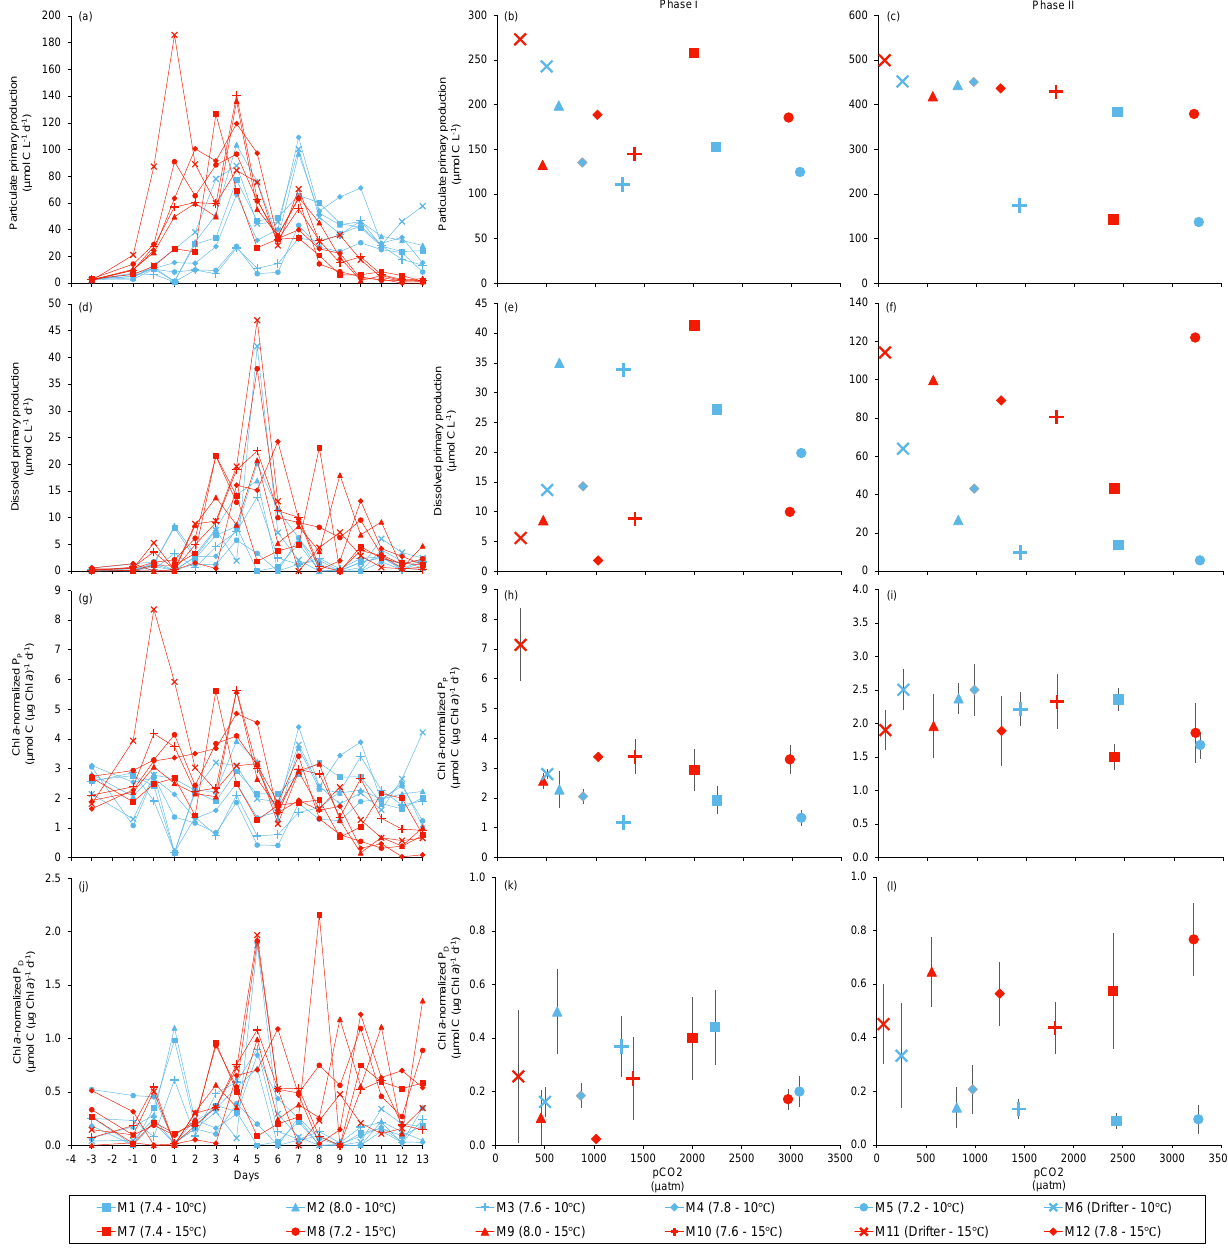
Figure 7. Temporal variations and time-integrated or averaged ± SE during Phase I (day 0 to day of maximum Chl a concentration) and Phase II (day after maximum Chl a concentration to day 13) for (a–c) particulate primary production, (d–f) dissolved primary production, (g–i) Chl a -normalized particulate primary production, and (j–l) Chl a -normalized dissolved primary production. For symbol attribution to treatments, see